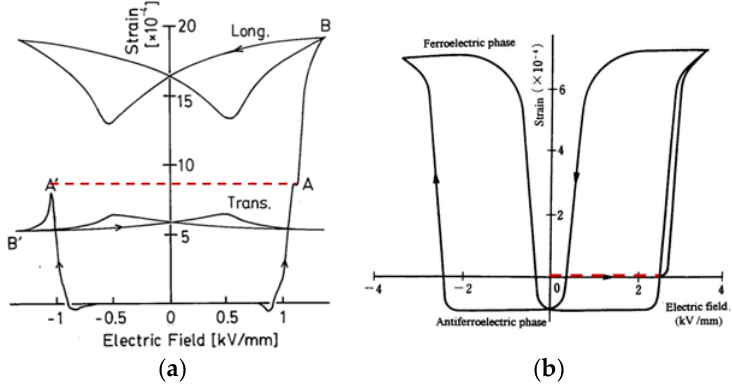
Figure 12. ( a ) Longitudinal and transverse induced strains in the sample Pb 0.99 Nb 0.02 [(Zr 0.6 Sn 0.4 ) 0.925 Ti 0.075 ] 0.98 O 3 ; and ( b ) transverse strains in Pb 0.99 Nb 0.02 [(Zr 0.6 Sn 0.4 ) 0.94 Ti 0.06 ] 0.98 O 3 .